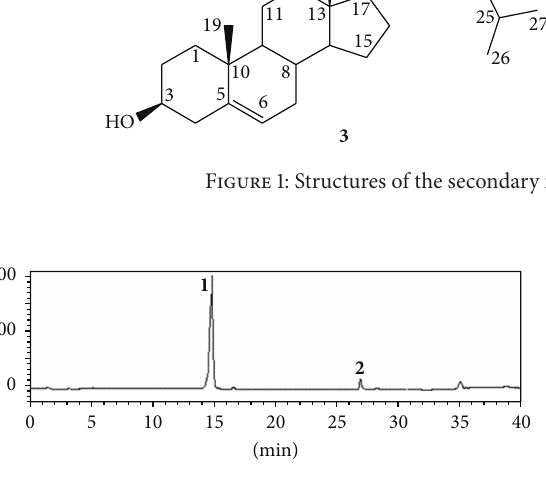
Figure 2: Chromatographic profile (HPLC) of the crude CH 2 Cl 2 extract from P . dilatatum roots. 1 , (+)-(7 S ,8 R )-epoxy- 5,6-didehydrokavain; 2 , flavokavain B. For chromatographic conditions, see Section 2.